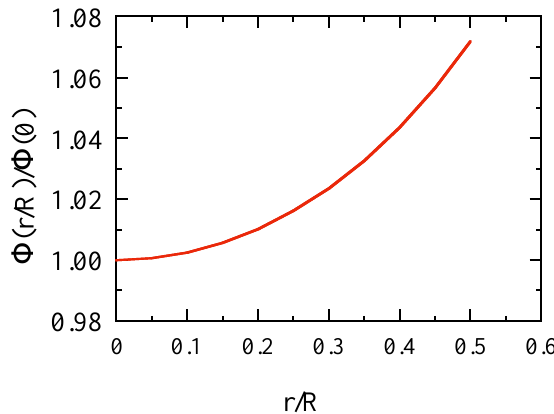
FIG. 3. (Color) Dependence of F on aspect ratio (cid:114) (cid:121) (cid:82) , for constant axial field.